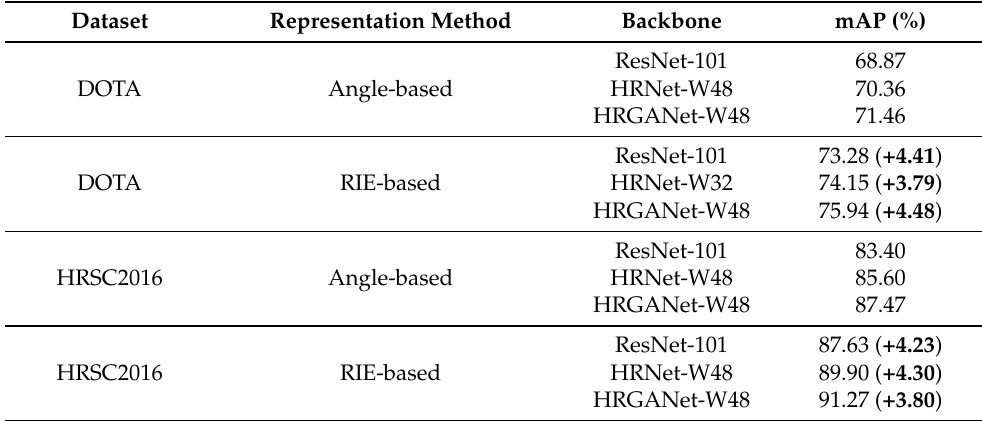
Table 5. Results of the comparison between the angle-based and RIE-based representation methods on the DOTA and HRSC2016 datasets based on three backbone networks.